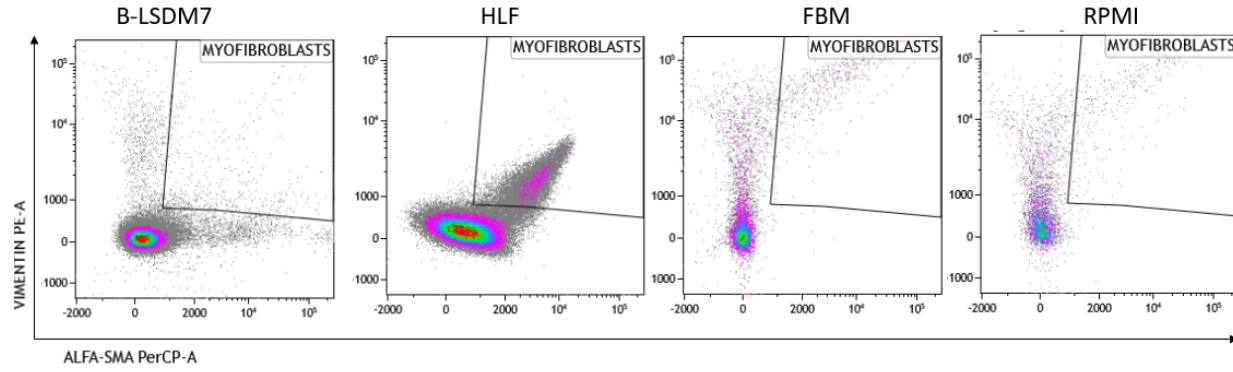
Figure 7. The Flow cytometric analysis of Vimentin and alfa-sma in B-LSDM7, HLF, FBM and RPMI cell lines.